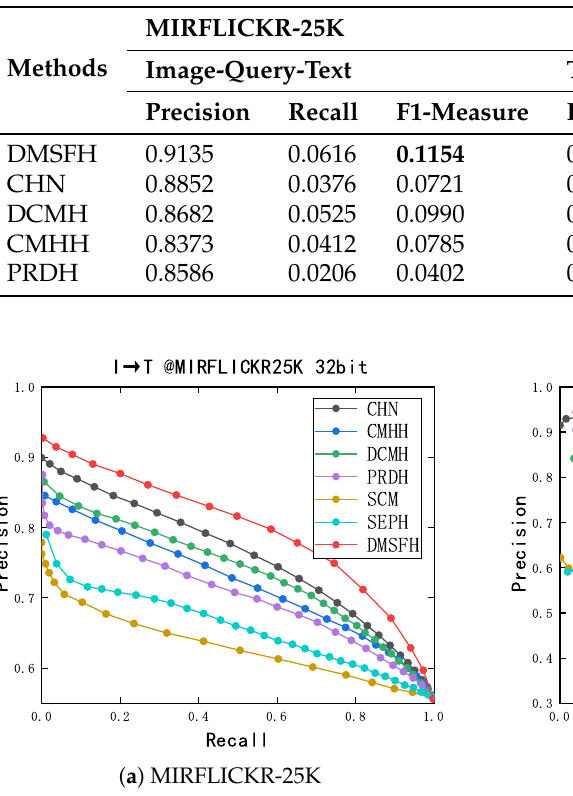
Figure 3. Precision–recall curves on MIRFLICKR-25K and NUS-WIDE. I → T query: ( a , b ); T → I query: ( c , d ). The code length was 16 bits. Table 5. F1-measures of our method and the competitors on MIRFLICKR-25K. The code length was 32 bit. The best results are in bold font.